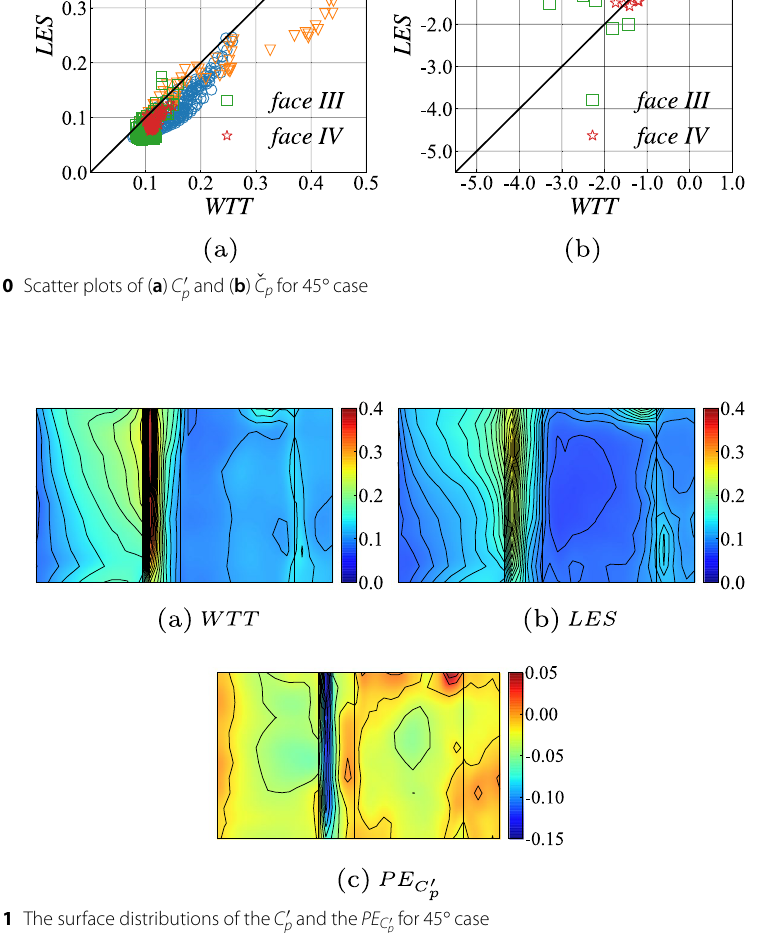
Fig. 11 The surface distributions of the C ′ p and the PE C ′